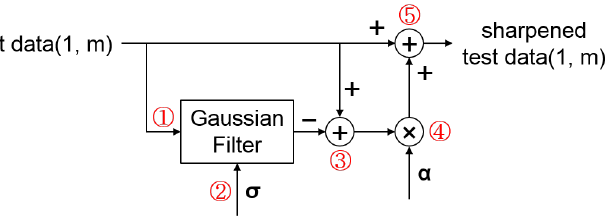
Figure 4. Test data sharpening using a Gaussian filter. Test data is first denoised using a Gaussian filter ( 1 (cid:13) ) using the σ parameter ( 2 (cid:13) ), and the denoised result is subtracted from the test data to obtain sharped details ( 3 (cid:13) ). The sharpened details are then amplified to some degree using α parameter ( 4 (cid:13) ) and added to the original test data to obtain sharpened test data ( 5 (cid:13)